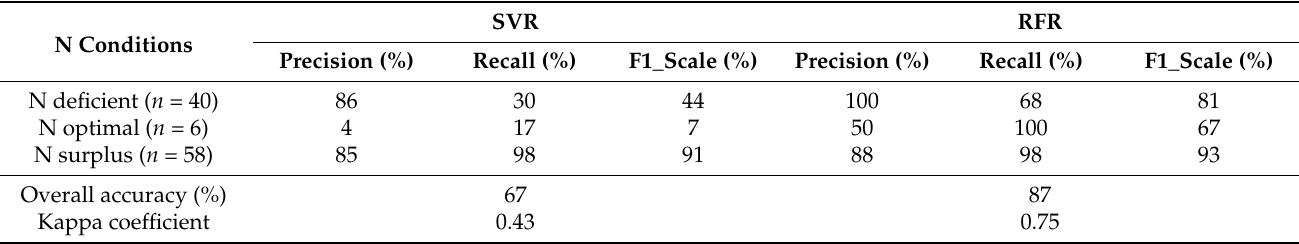
Table 8. Corn N status diagnostic results based on the predicted N nutrition index (NNI) using support vector regression (SVR) and random forest regression (RFR) with NDRE, NDVI plus genetic, environmental, and management data for the prediction dataset ( n =